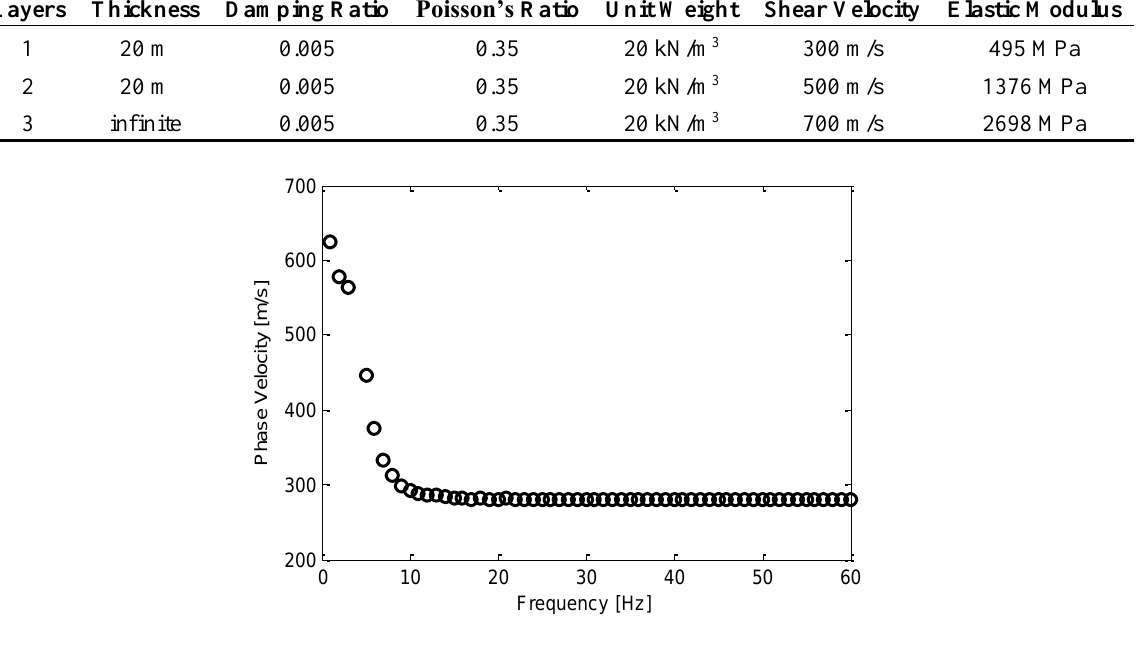
Figure 8. Analytical dispersion curve (dominant mode).